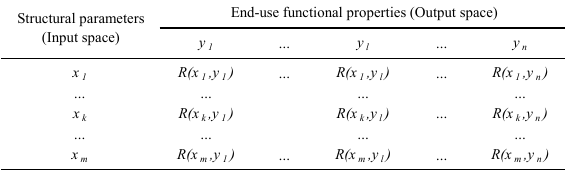
Table 1. Formalization of the human knowledge table.